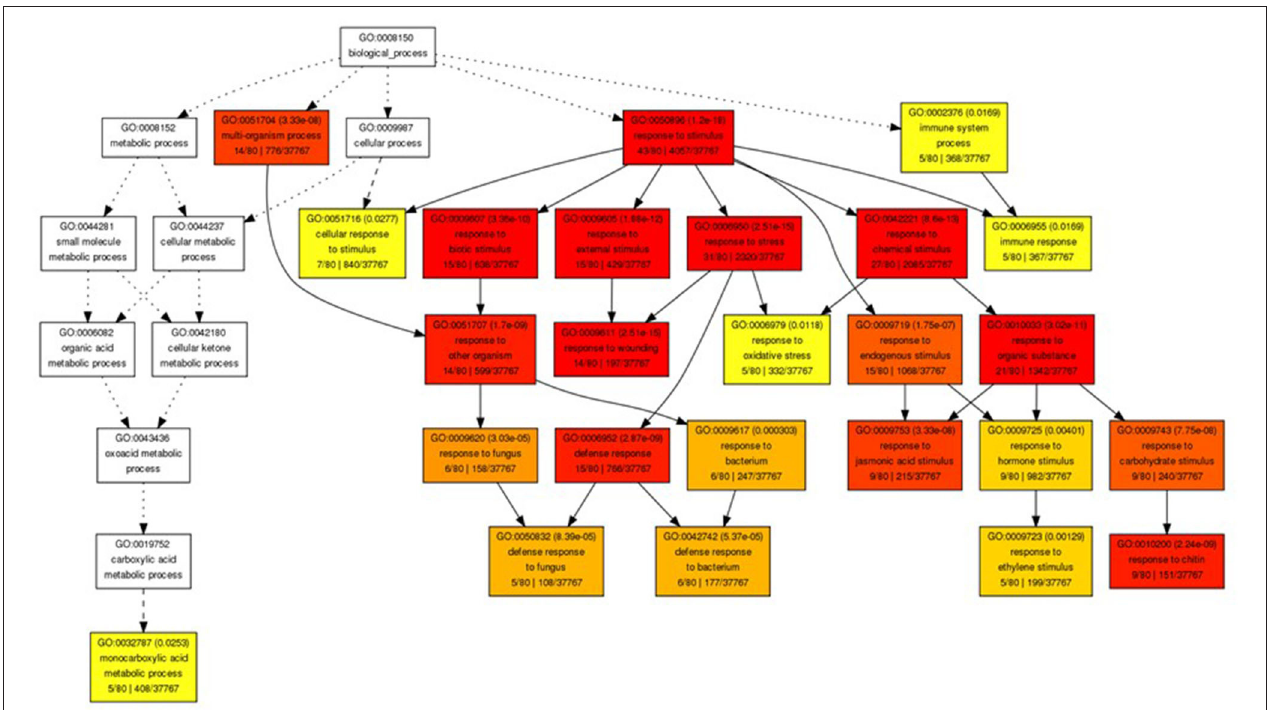
FIGURE 6 | Gene ontology (GO) analysis of genes with altered expression in Ws-4 wild type and gpt2 plants. Graphical representation of a GO hierarchical image containing all statistically significant terms between gpt2 HL/WTHL at Day 7. These nodes in the image are classified with specific corresponding colours. The smaller the adjusted p -value of the term, the more significant statistically, and the darker and redder the colour of the node. Inside the box of the significant terms, the information includes the GO term, adjusted p -value, GO description, item number mapping the GO in the query list and background, and the total number of query list and backgrounds. Image produced using online GO Analysis Toolkit and Database for Agricultural Community